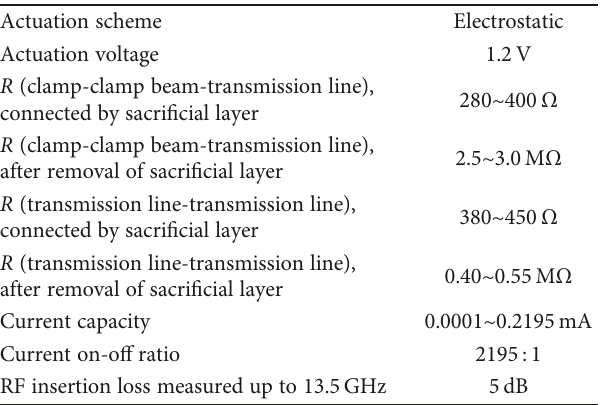
Table 6: An upfront summary of the performance of the printed MEMS